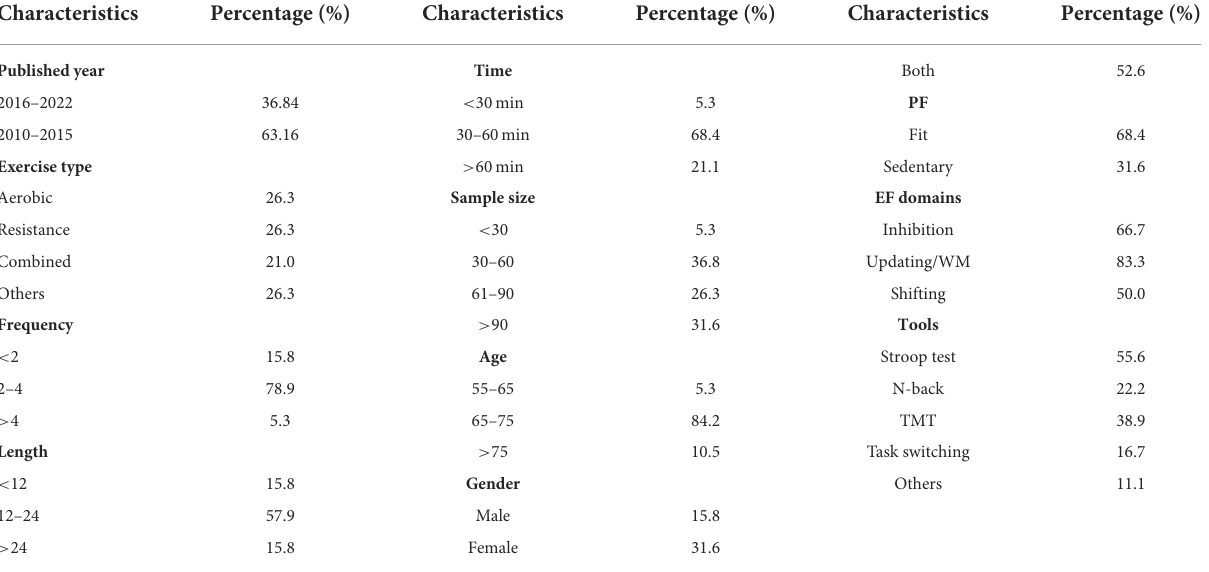
TABLE 2 Summary of intervention characteristics of included studies.